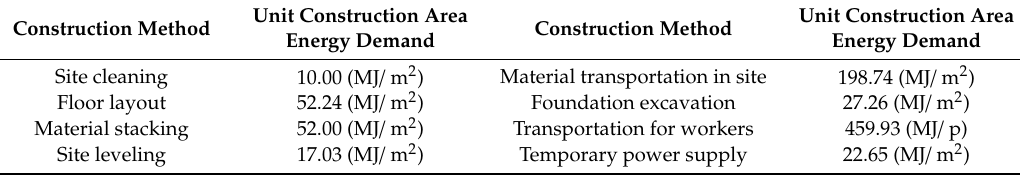
Table A3. Unit energy demand in some common construction methods (MJ / m 2 ).